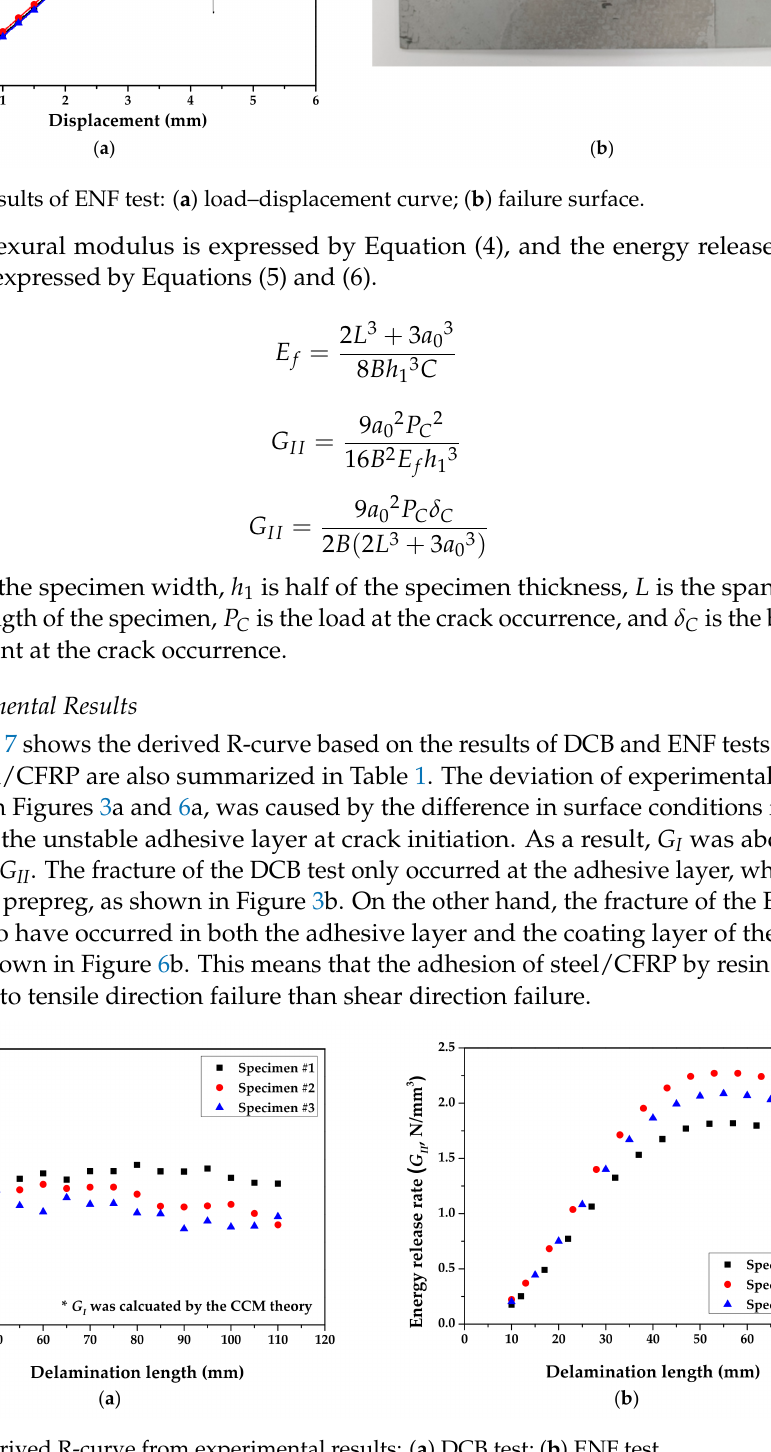
Figure 7. Derived R-curve from experimental results: ( a ) DCB test; ( b ) ENF